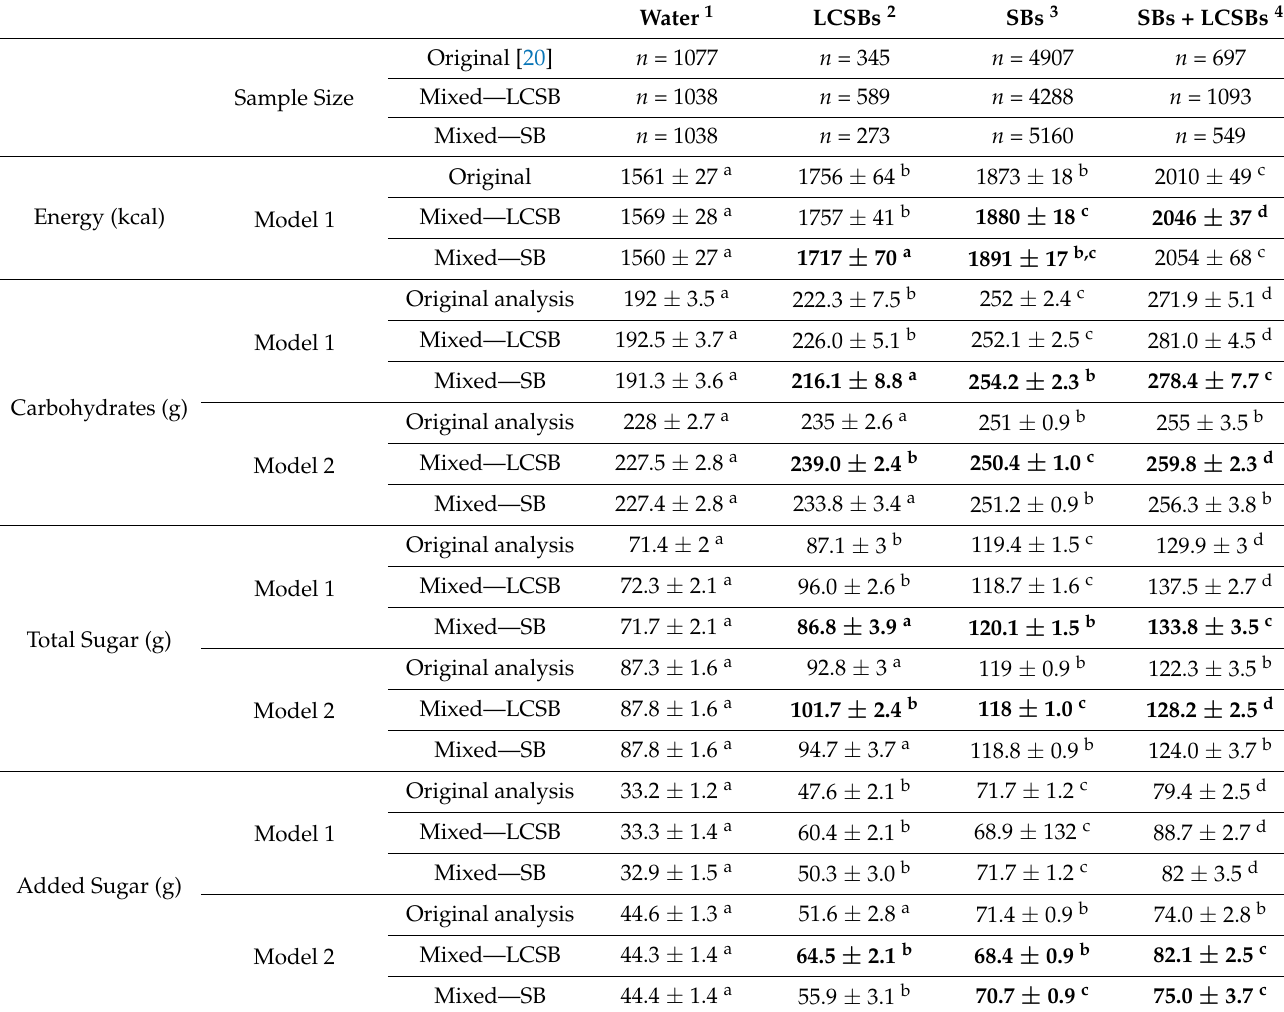
Table 5. Least square means and standard errors of energy and selected macronutrient intakes in US children and adolescents (2–17 y), NHANES 2011–2016, from original published analysis [7] compared with re-analyses in which all mixed foodcodes were categorized either as LCSBs or as